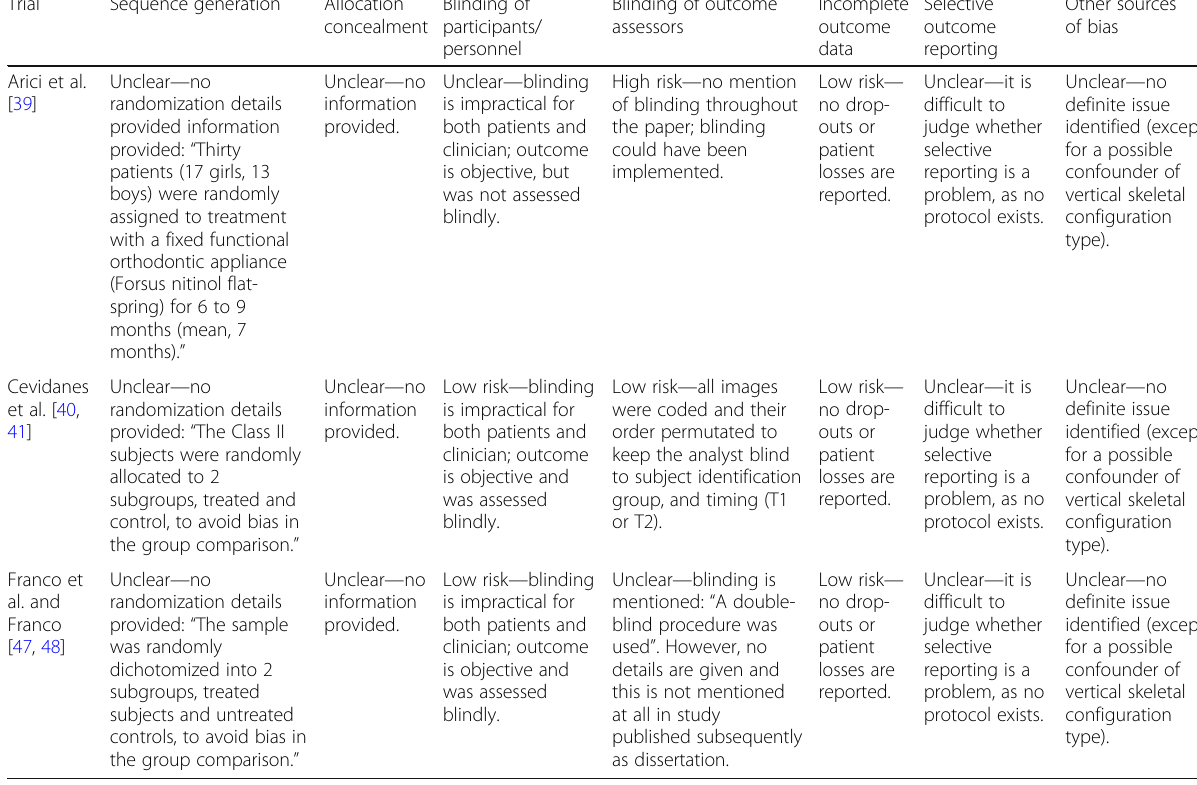
Table 2 Risk of bias of the included randomized clinical trials with the Cochrane risk of bias tool Trial Sequence generation